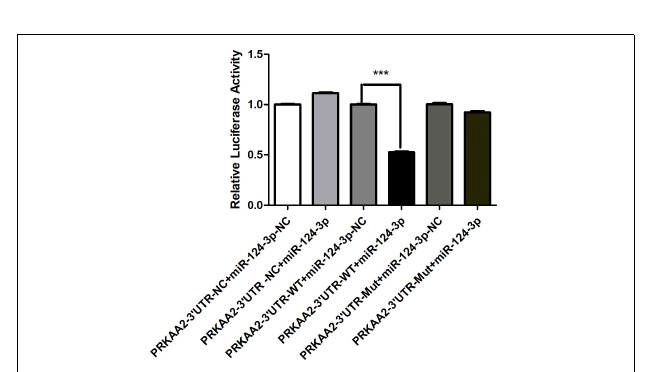
FIGURE 8 | MiR-124-3p targeted PRKAA2 3’UTR in HEK 293T cells. pcDNA3.1(-)-miR124-3p was co-transfected with luciferase reporter constructs containing pGL3-PRKAA2-3’UTR-WT or pGL3-PRKAA2-3’UTR-MUT in 293T cells; Firefly luciferase activity for each construct was normalized to the co-transfected Renilla luciferase construct presented miRNA-124-3p-NC transfected group. The data are presented as the means ± SD ( n = 3, *** P < 0.001, PRKAA2-3’UTR-WT + miR-124-3p vs. PRKAA2-3’UTR-WT +